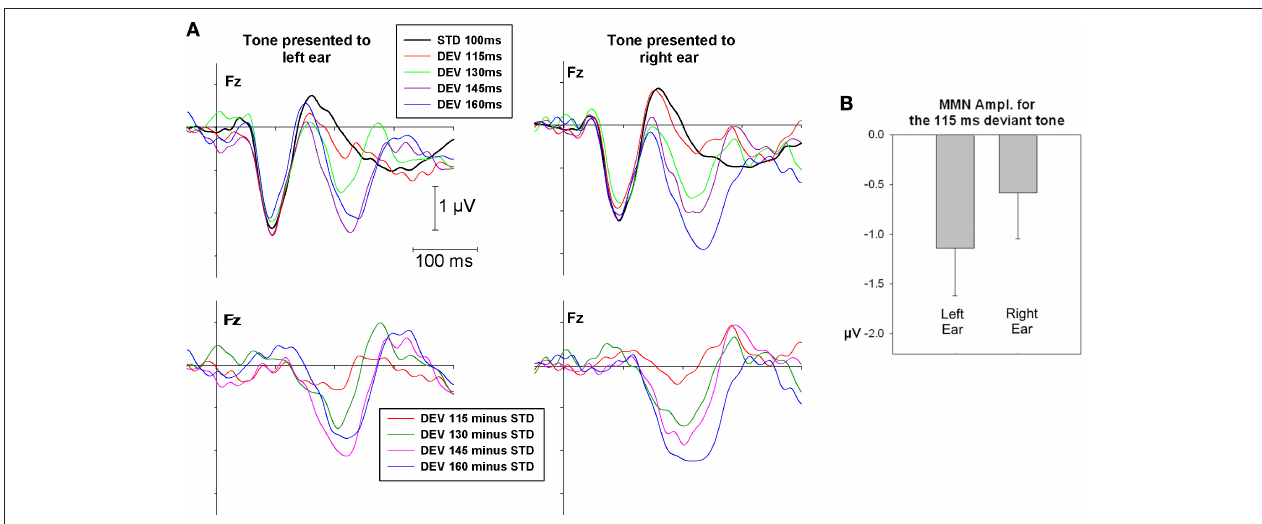
FIGURE 2 | (A) Grand mean ERPs at Fz for standard and deviant tones of 115, 130, 145 and 160 ms duration presented to the left and right ear (top panel) as well as MMN response (bottom panel) as subtraction waveform (deviant − standard). (B) Average MMN amplitude and standard error for the 115 ms deviant presented to the left and right